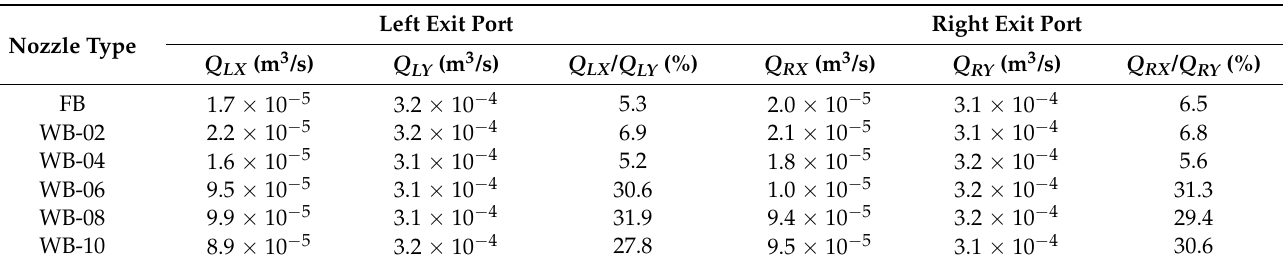
Table 1. Oriented volumetric flows for nozzles analyzed in Figures 5 and